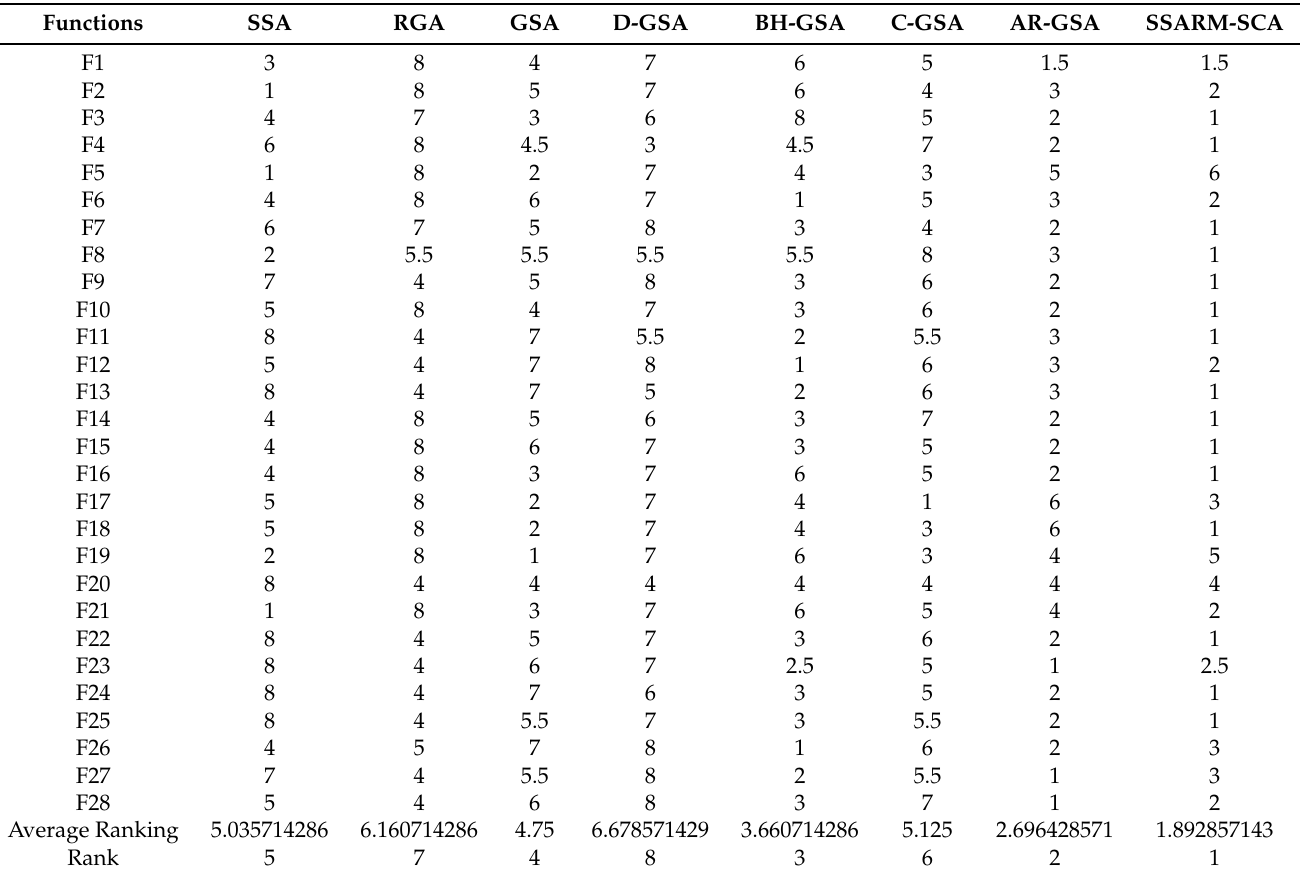
Table 5. Friedman test ranks for the compared algorithms over 28 CEC2013